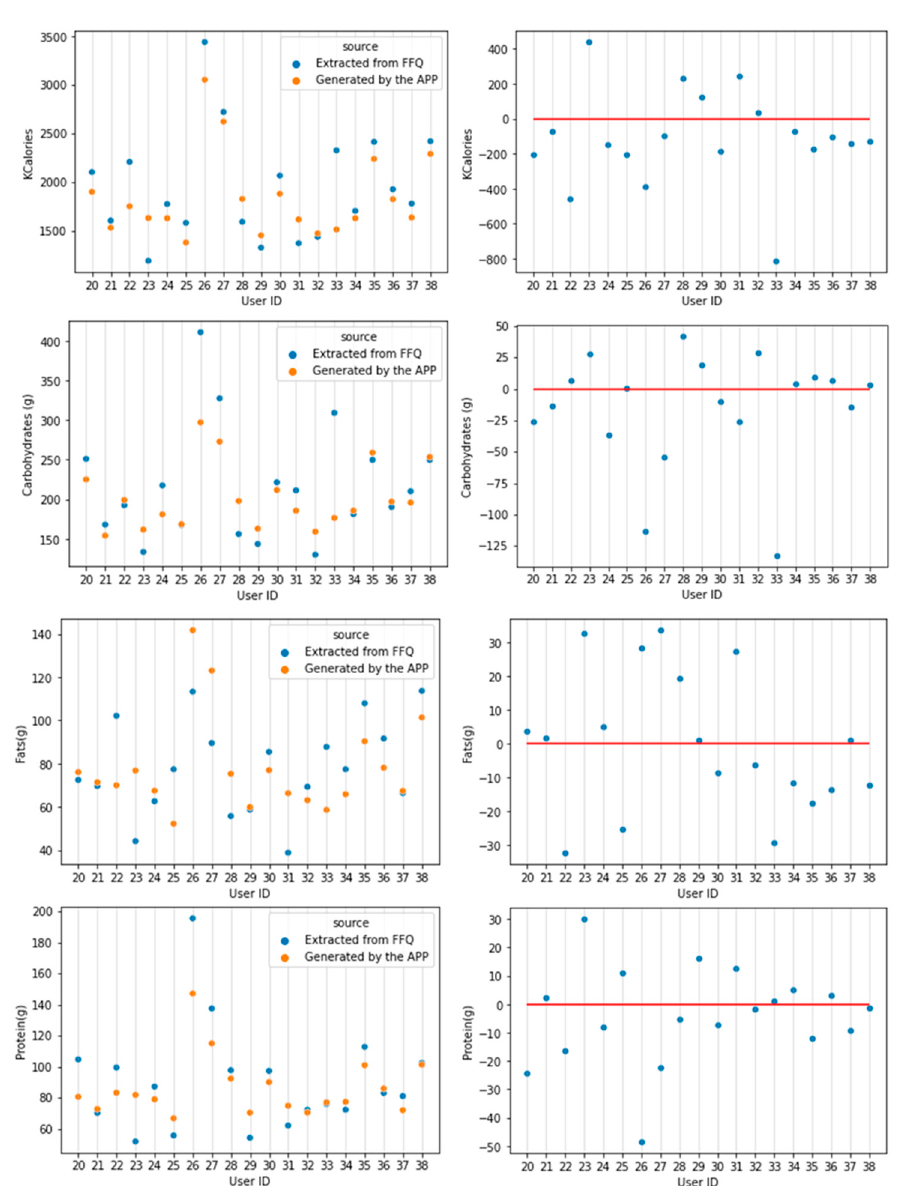
Figure 5. Energy and macronutrient comparisons from APP vs. FFQ ( left ) and differences APP-FFQ ( right ). Positive values mean APP levels were higher; negative values imply APP levels were lower.